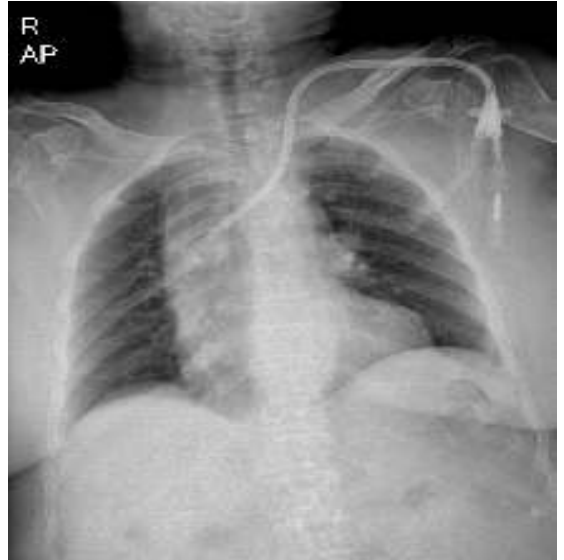
Figure 1. Chest X-ray of patient before removal of catheter; mediastinal widening being evident and tip of catheter being extraluminal